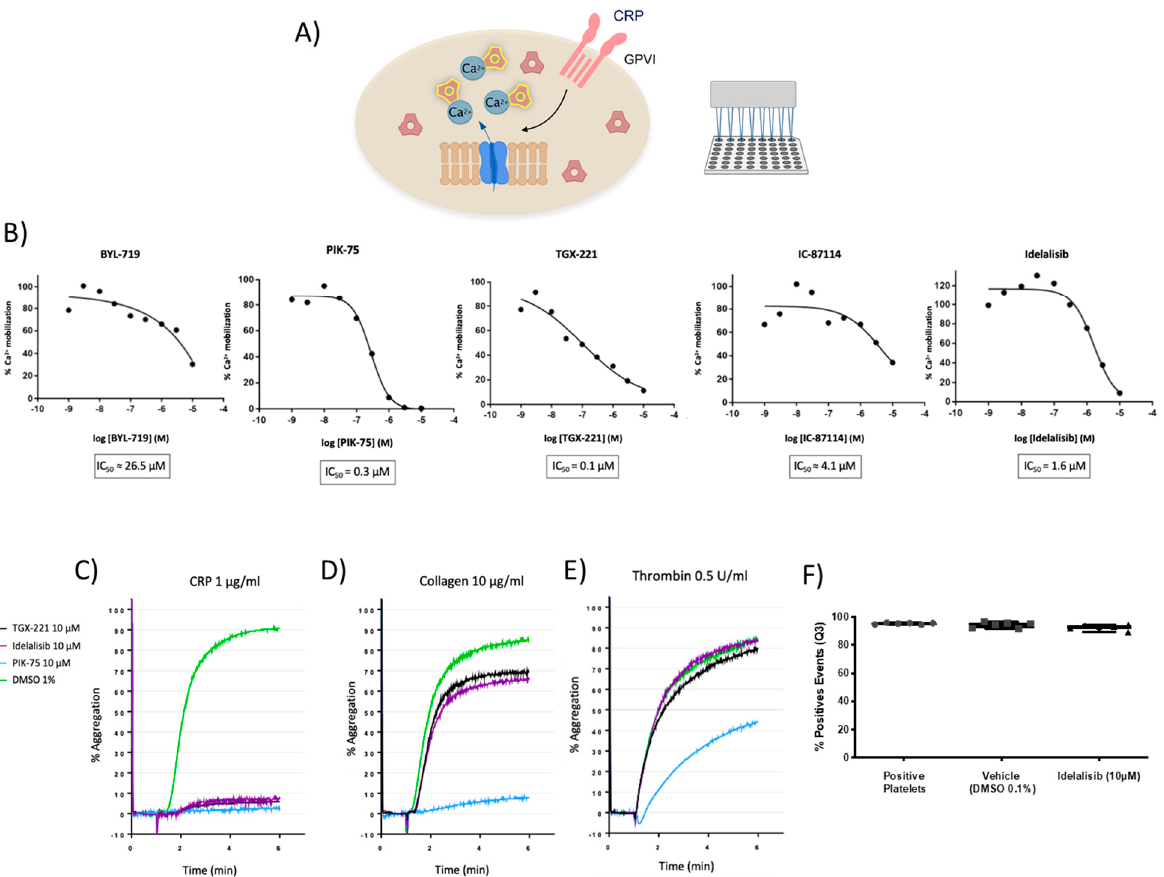
Figure 1. Effect of PI3K inhibitors on platelet activation based on intracellular calcium mobilization and aggregation assays. ( A ) Schematic representation of the intracellular calcium mobilization assay. For detailed information please see the Methods section. ( B ) TGX-221, Idelalisib, and PIK-75 block intracellular calcium release mediated by Collagen-Related Peptide (CRP)-induced GPVI-activation with micromolar potency, whereas IC-87114 and BYL-719 have a weaker effect. ( C – E ) Representative aggregation curves of platelets treated with TGX-221, and Idelalisib, and PIK-75 from two independent experiments. Inhibitors completely block CRP-mediated platelet aggregation with a less pronounced effect inhibiting collagen-mediated aggregation and no effect on thrombin-mediated aggregation. In the case of PIK-75, it blocks, totally or moderately, platelet aggregation induced by either CRP, collagen, or thrombin. ( F ) Calcein-AM-based viability assay demonstrating platelets are viable following 10 μ M Idelalisib treatments.